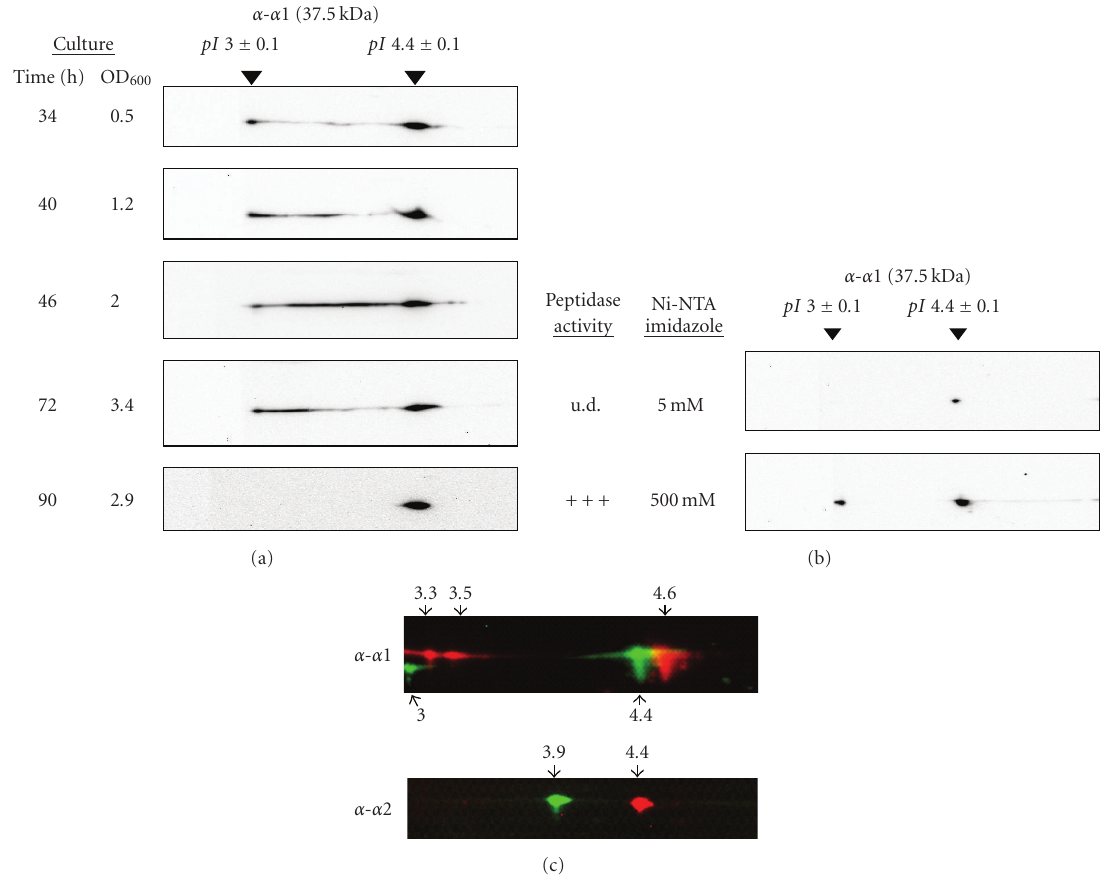
Figure 1: Phosphatase-sensitive isoforms of α -type proteins of proteasomal CPs as a function of growth in H. volcanii cells. (a) An α 1 isoform of pI 4.4 was present at all stages of growth with a more acidic isoform of pI 3.0 present in log- and early-stationary phase, but absent in late-stationary phase. Cell lyase was prepared from various stages of growth as indicated (1 OD 600 unit ∼ 1 × 10 9 CFU · mL − 1 ), separated by 2-DE and analyzed by immunoblot using anti- α 1 antibody ( α - α 1). (b) The two α 1 isoforms of pI 3.0 and 4.4 are associated in proteasomal CPs. Proteasomal CPs were purified by Ni-NTA chromatography from early stationary-phase cells expressing β -His 6 . Proteins were separated into two fractions: (i) flowed through the Ni-NTA column at 5mM imidazole and (ii) bound and were eluted from the column at 500 mM imidazole. Protein fractions were separated by 2-DE and analyzed by immunoblot using anti- α 1 antibody ( α - α 1). Fractions were also assayed for peptidase activity using Suc-LLVY-AMC. u.d., undetectable. (c) Both α 1 and α 2 isoforms are sensitive to phosphatase treatment. Proteasomal CPs (purified as above) were treated with (red) and without (green) phosphatase, separated by 2-DE, and probed by immunoblot with anti- α 1 and anti- α 2 antibodies as indicated ( α - α 1 and α - α 2,